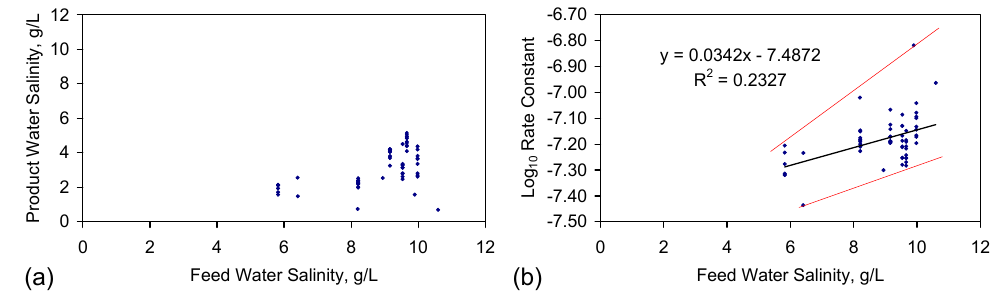
Figure B2. Desalination associated with ZVI catalyst pellet desalination. Type A catalyst (ST) [16]. n = 59; ( a ) Feed Water Salinity vs. Product Water Salinity; ( b ) Feed water salinity vs. Log 10 Rate Constant, k 10 . Red lines indicate the upper and lower bounds of the data set. The black line is the regression trend. Data: [16].